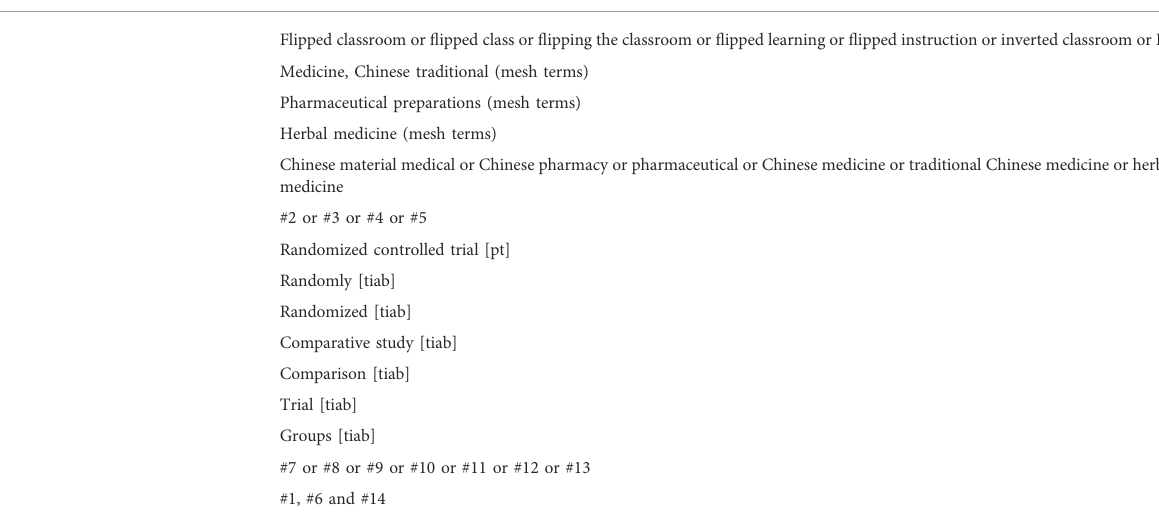
TABLE 1 Search strategy for the